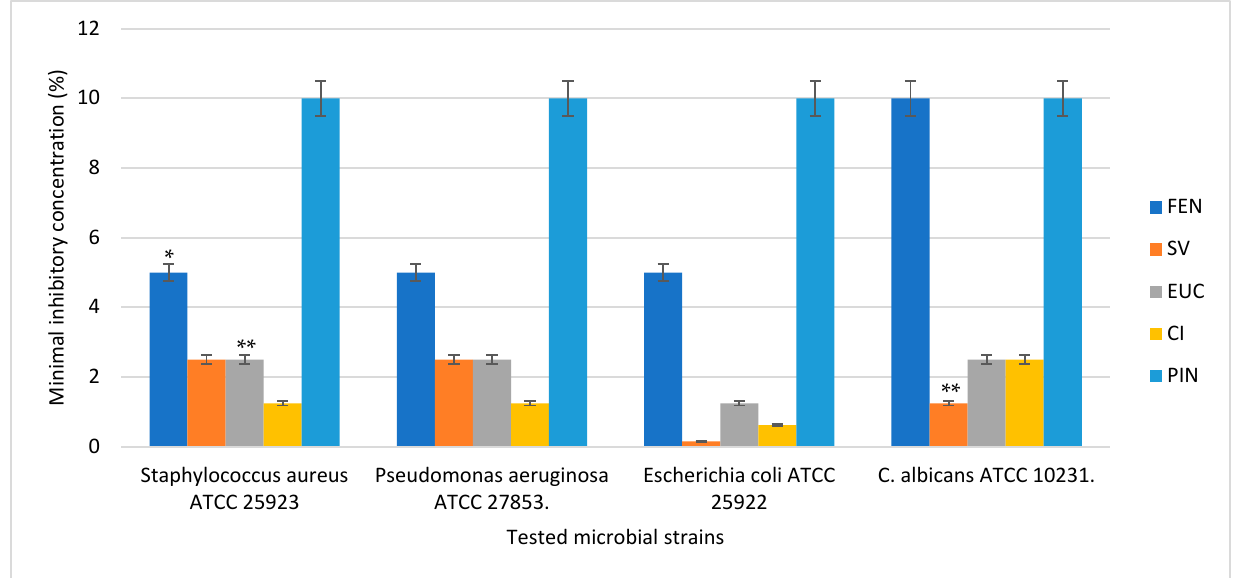
Figure 7. Graphical representation of MIC values expressed as a percentage (percentage of oil in the culture medium) for each tested microbial strain; FEN (fennel EO); SV (sage EO); EUC (eucalyptus EO); CI (thyme EO); PIN (pine EO); significant results regarding the MIC values were noted as: * for p < 0.05, and ** for p < 0.01 ( statistically significant results; statistic interpretation using one-way ANOVA repeated measures test).